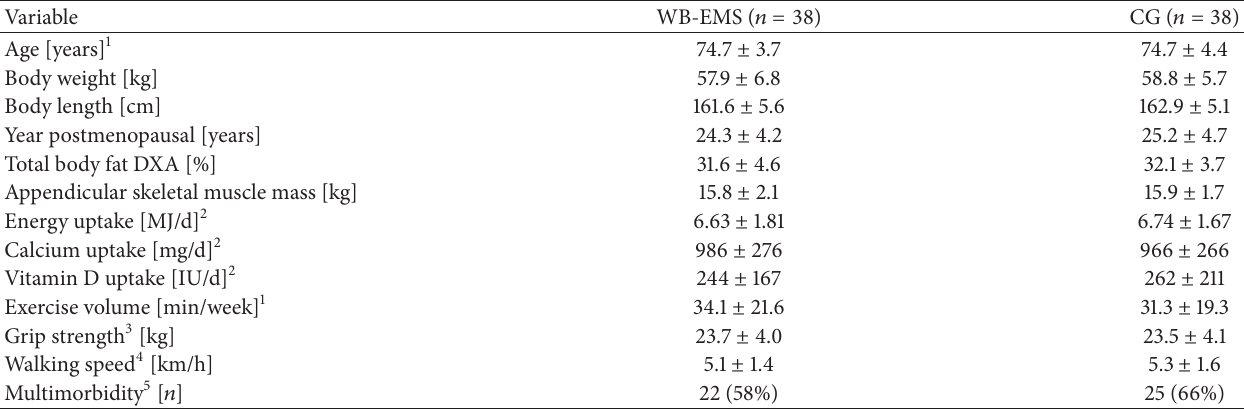
Table 1: Baseline characteristics of the WB-EMS and control group. WB-EMS: whole-body electromyostimulation. 1 As assessed by detailed questionnaires (14, 15). 2 As assessed by 4-day protocol and analyzed using Prodi-4.5/03 Expert software (Wissenschaftlicher Verlag, Freiburg, Germany). 3 As assessed by Jamar dynamometer (dominant hand) according to Mathiowetz et al. [14]. 4 Test according to Fritz und Lusardi [15]. 5 Prevalence of two and more